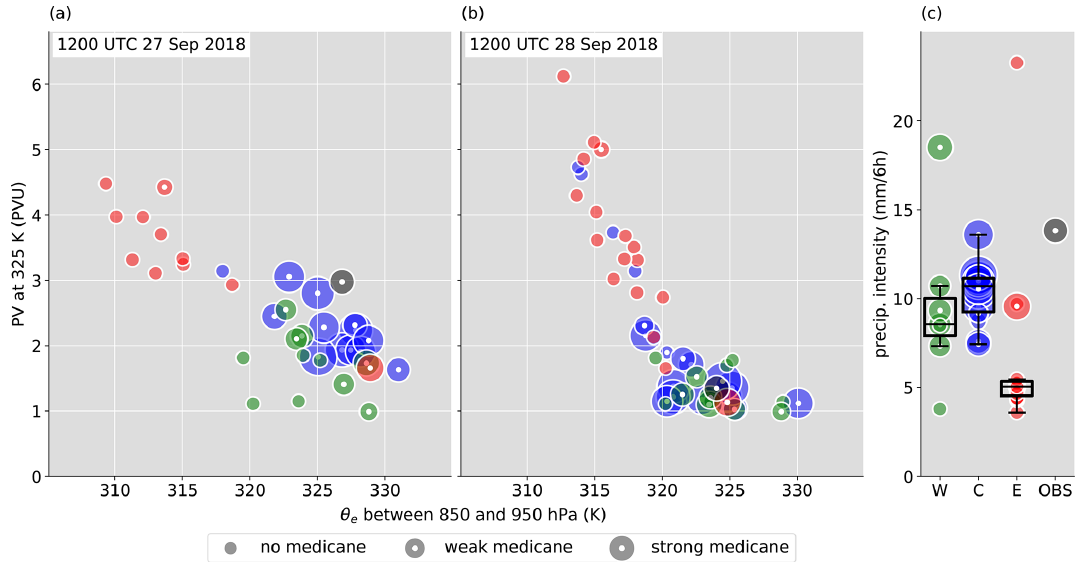
Figure 12. (a, b) Diagram of low-level θ e vs. upper-level PV for all ensemble members with a cyclone and for the operational analysis at (a) 12:00UTC 27 September 2018 and (b) 12:00UTC 28 September 2018; markers and times are as in Fig. 6. (c) Average precipitation intensity within a 250km radius around the cyclone center between 12:00UTC 27 September and 12:00UTC 28 September 2018 for all cyclones present during the full 24h period as individual data points (colored markers) and standard box plots (black). The observation (OBS) is based on TRMM rainfall data along the track in the operational